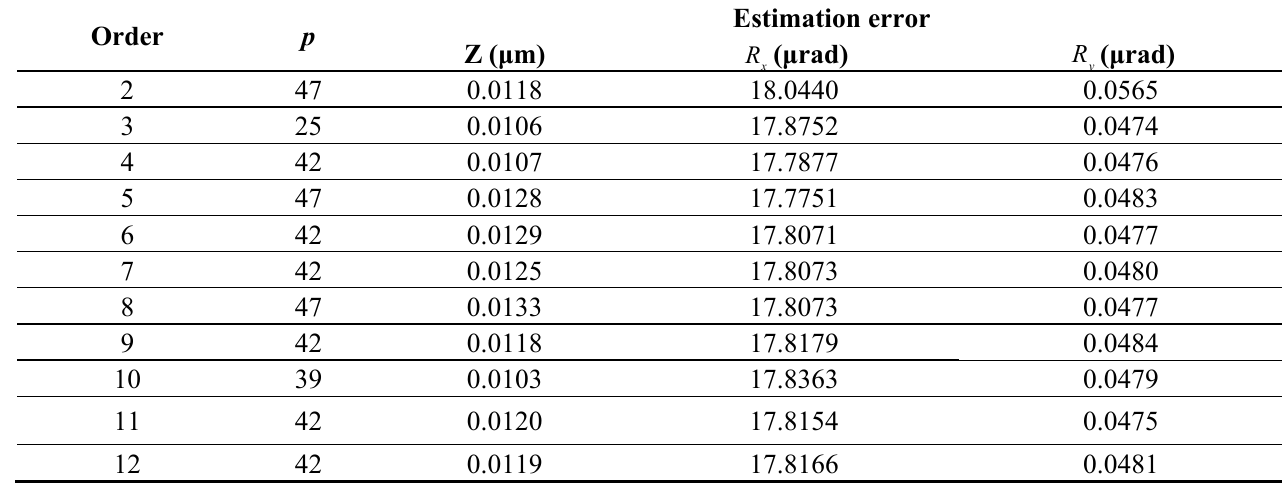
Table 5. Estimation error from the chirp inputs in channel